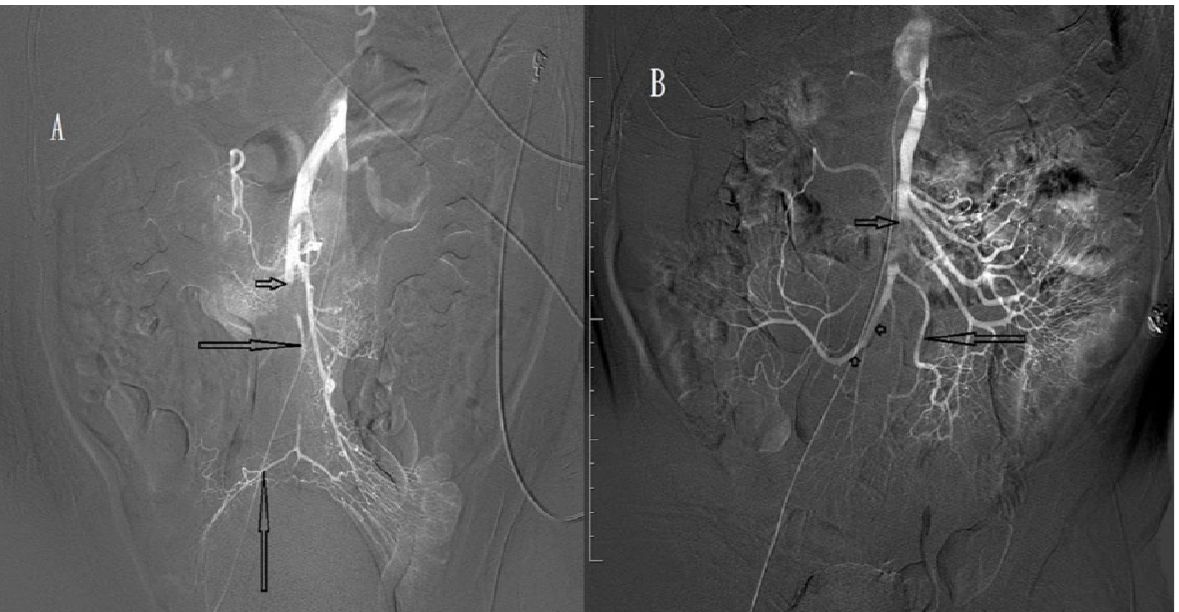
Figure 2. ( A ) Angiography of a 67-year-old man, showing incomplete occlusion (short arrow) of the superior mesenteric artery (SMA). Distal main trunk of the SMA and ileocolic artery (long arrows) are visible. ( B ) Angiography of a 78-year-old man, showing incomplete occlusion (short arrow) of the SMA. The ileal artery (long arrow) and ileocolic artery (arrowheads) are